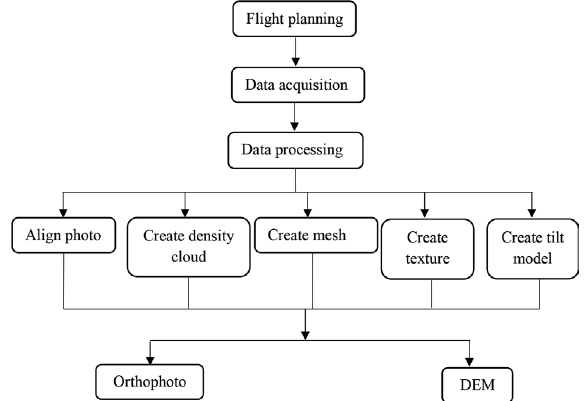
Fig. 4. Workflow of the UAV survey and data